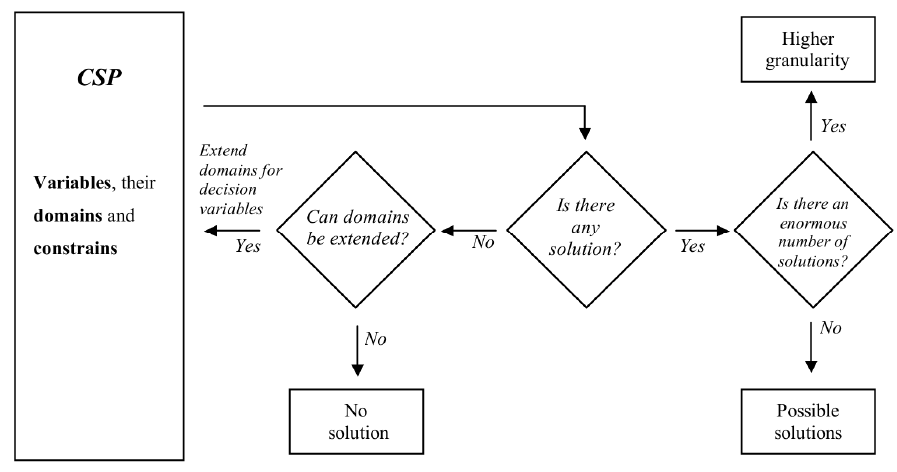
Figure 4. A framework for solving the inverse form of the project prototyping problem.